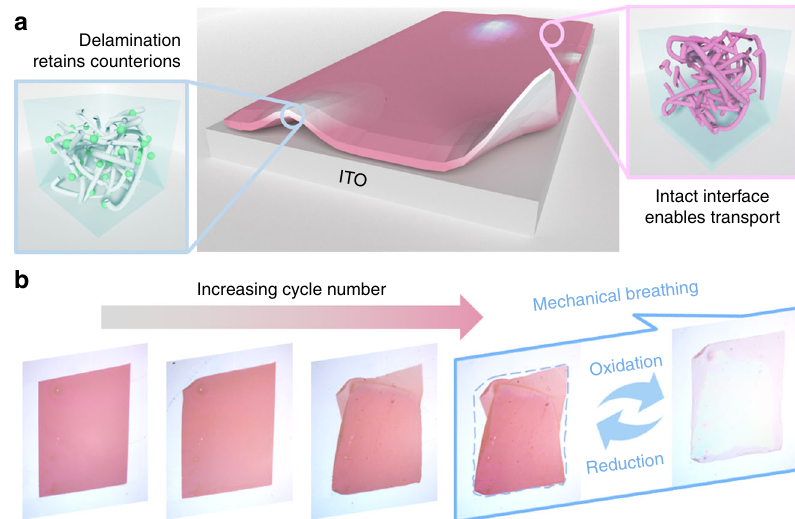
Fig. 1 Sketch of interfacial delamination in thin fi lm electrochromic devices. a The mechanical delamination from the current collector limits electron and counterion transport and impedes chromic switch of the fi lm upon electrochemical cycles. b Experimental observation of mechanical breathing of PProDOT fi lm and its morphology after every 60 cycles. The thin fi lm experiences repetitive expansion and shrinkage in volume in the redox reactions which ultimately leads to the failure of the device at the interface.